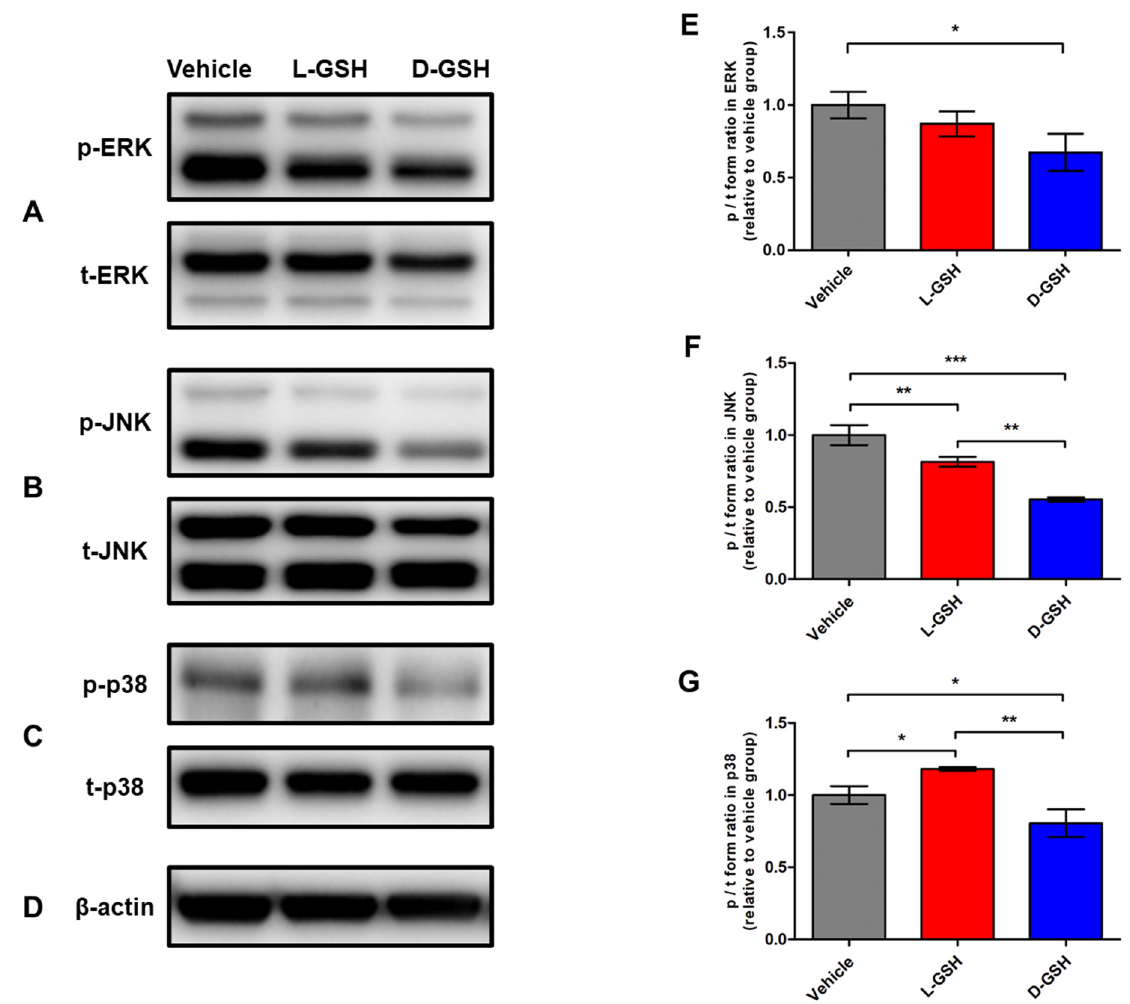
Figure 6. The phosphorylation activities of the MAPK signaling pathway in the vehicle, L-GSH, and D-GSH groups. Representative images of the p and t forms of ( A ) ERK, ( B ) JNK, ( C ) p38, and ( D ) β -actin. Quantitative analyses of the p/t forms of ( E ) ERK, ( F ) JNK, and ( G ) p38. The p/t form volume in the vehicle group was set to 1-fold, and the ratio was relatively calculated and quantified. Results are the mean ± SEM; * p < 0.05, ** p < 0.01, and *** p < 0.001; one-way ANOVA with Tukey post hoc test.